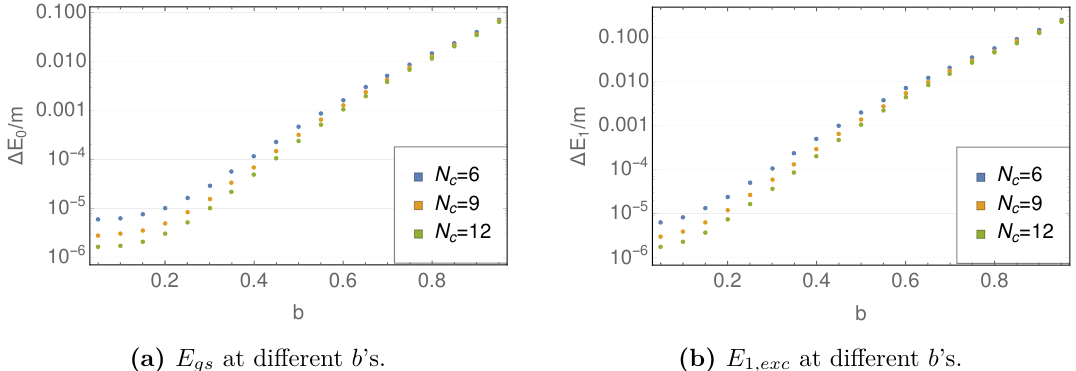
Figure 5. Here we present results on the behavior of the ground state energy (a) and first excited state (b) as a function of b at fixed M ShG R = 1 . We present results for 3 different values of the cutoff ( N c = 6 , 9 , 12 , N ZM =24). The energies are normalized with respect to the free mass m . We have plotted the results as differences between the numerical values and the expected exact values from TBA.